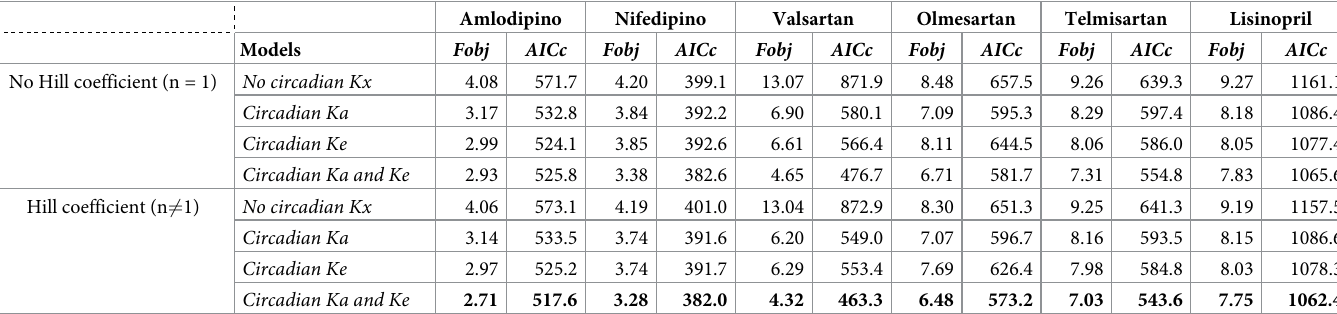
Table 1. Objective function ( Fobj ) and corrected Akaike information criterion ( AICc ) values for non-prodrug tested